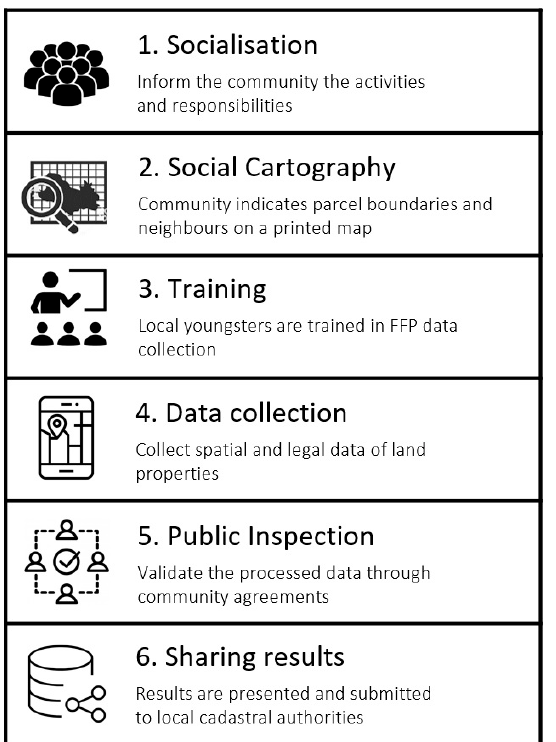
Figure 1. The fit-for-purpose (FFP) methodology steps as applied in the Colombian Land in Peace Project. Elaborated by the authors. Source: Land in Peace Project, Kadaster.